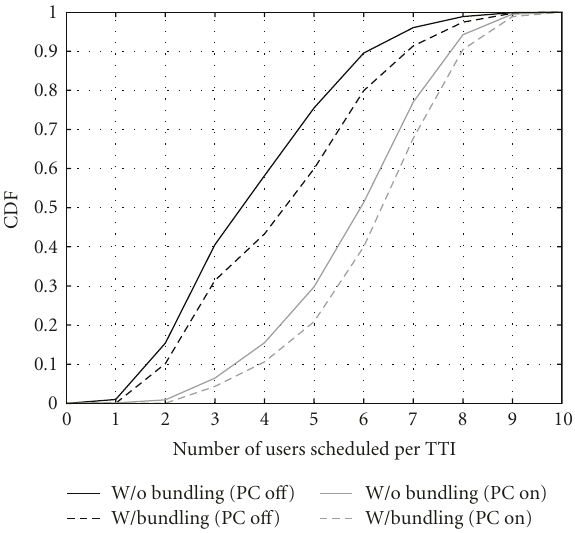
Figure 7: CDF of the number of users scheduled per TTI (Macro Case 3).